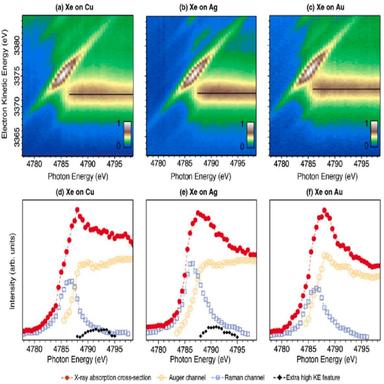
(Top) Maps of the electron kinetic energy distributions measured in the range of Xe L3M4, 5M4, 5 Auger electrons upon X-ray excitation scanned over the Xe L3-edge on (a) Cu, (b) Ag, and (c) Au. (Bottom) X-ray absorption cross sections obtained from the row-wise intensity sum of the 2D-maps with partial yields created from a least squares fit to the electron spectra on (d) Cu, (e) Ag, and (f) Au .